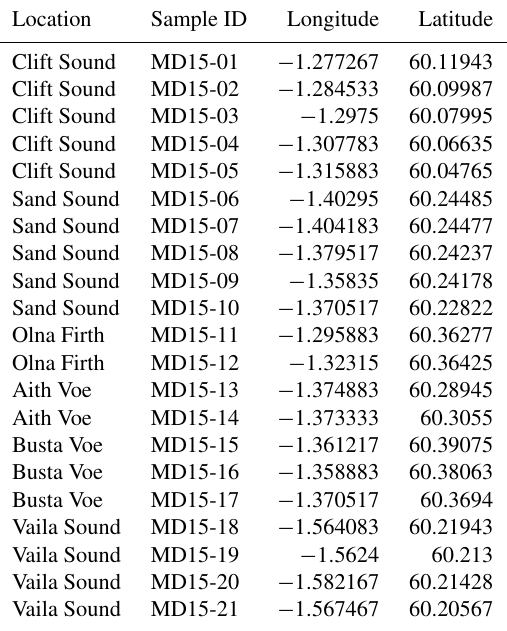
Table 1. Station